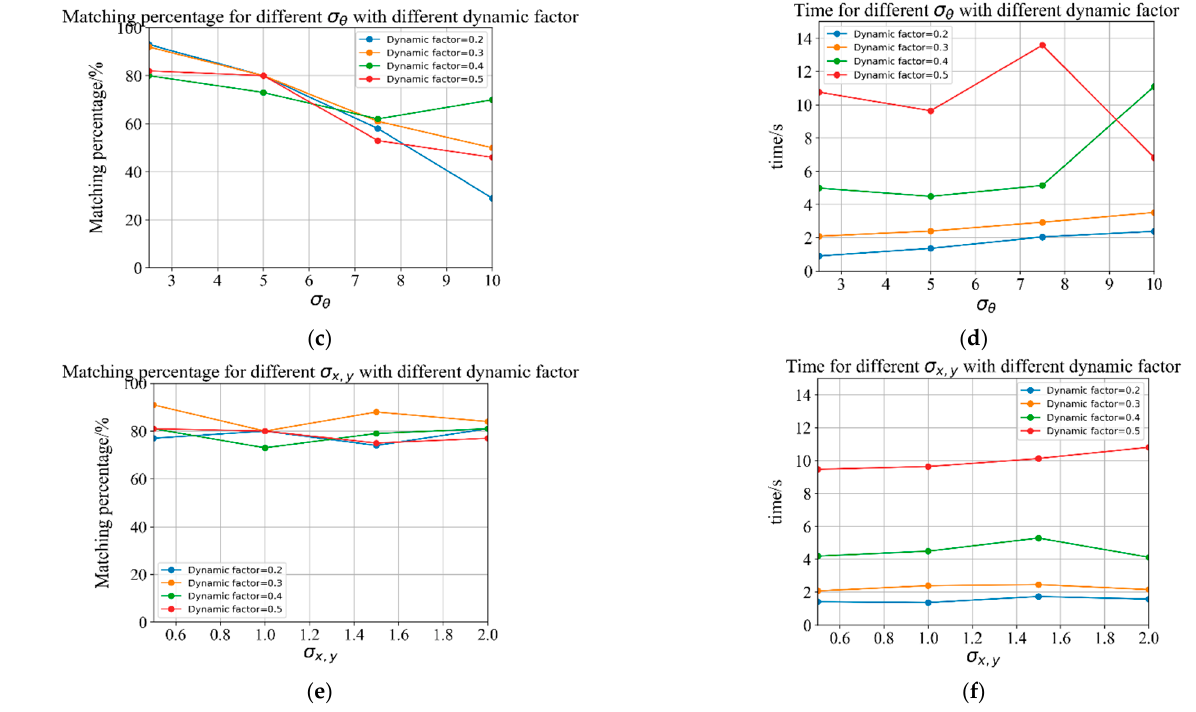
Figure 15. Matching rate and time consumed for different σ a , b , σ θ , and σ x , y with different dynamic factors. ( a ) Matching rate for different σ a , b ; ( b ) Time consumed for different σ a , b ; ( c ) Matching rate for different σ θ ; ( d ) Time consumed for different σ θ ; ( e ) Matching rate for different σ x , y ; ( f ) Time consumed for different σ x , y .